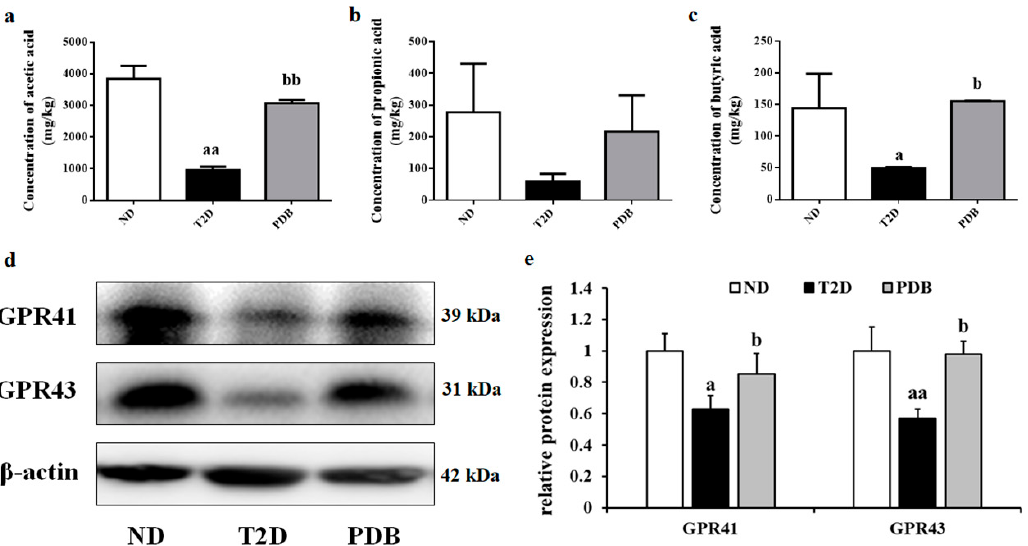
Figure 8. Effects of PDB supplementation on the SCFAs levels and protein expression of GPR41 and GPR43 in diabetic mice. Acetic acid ( a ), propionic acid ( b ), and butyric acid ( c ) content of feces samples were detected by GC-MS. The protein expression of GPR41 and GPR43 in colon tissue was determined by western blot ( d , e ). Data are presented as mean ± SD, a p < 0.05, aa p < 0.01 versus the ND group. b p < 0.05, bb p < 0.01 versus the T2D group.